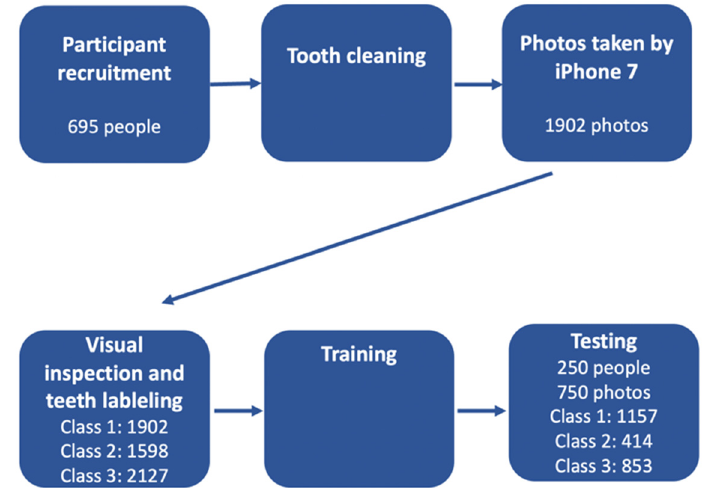
Figure 2. The flow chart of the